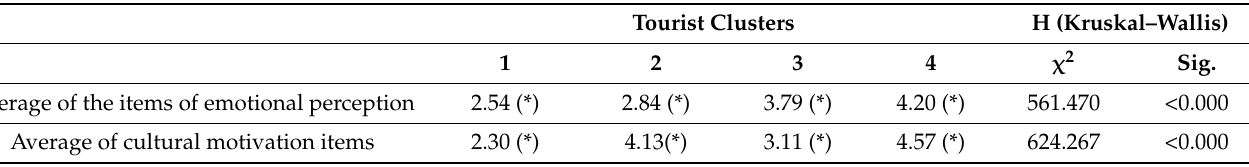
Table 1. Characterisation of the perception of historical heritage and cultural interest. Tourist